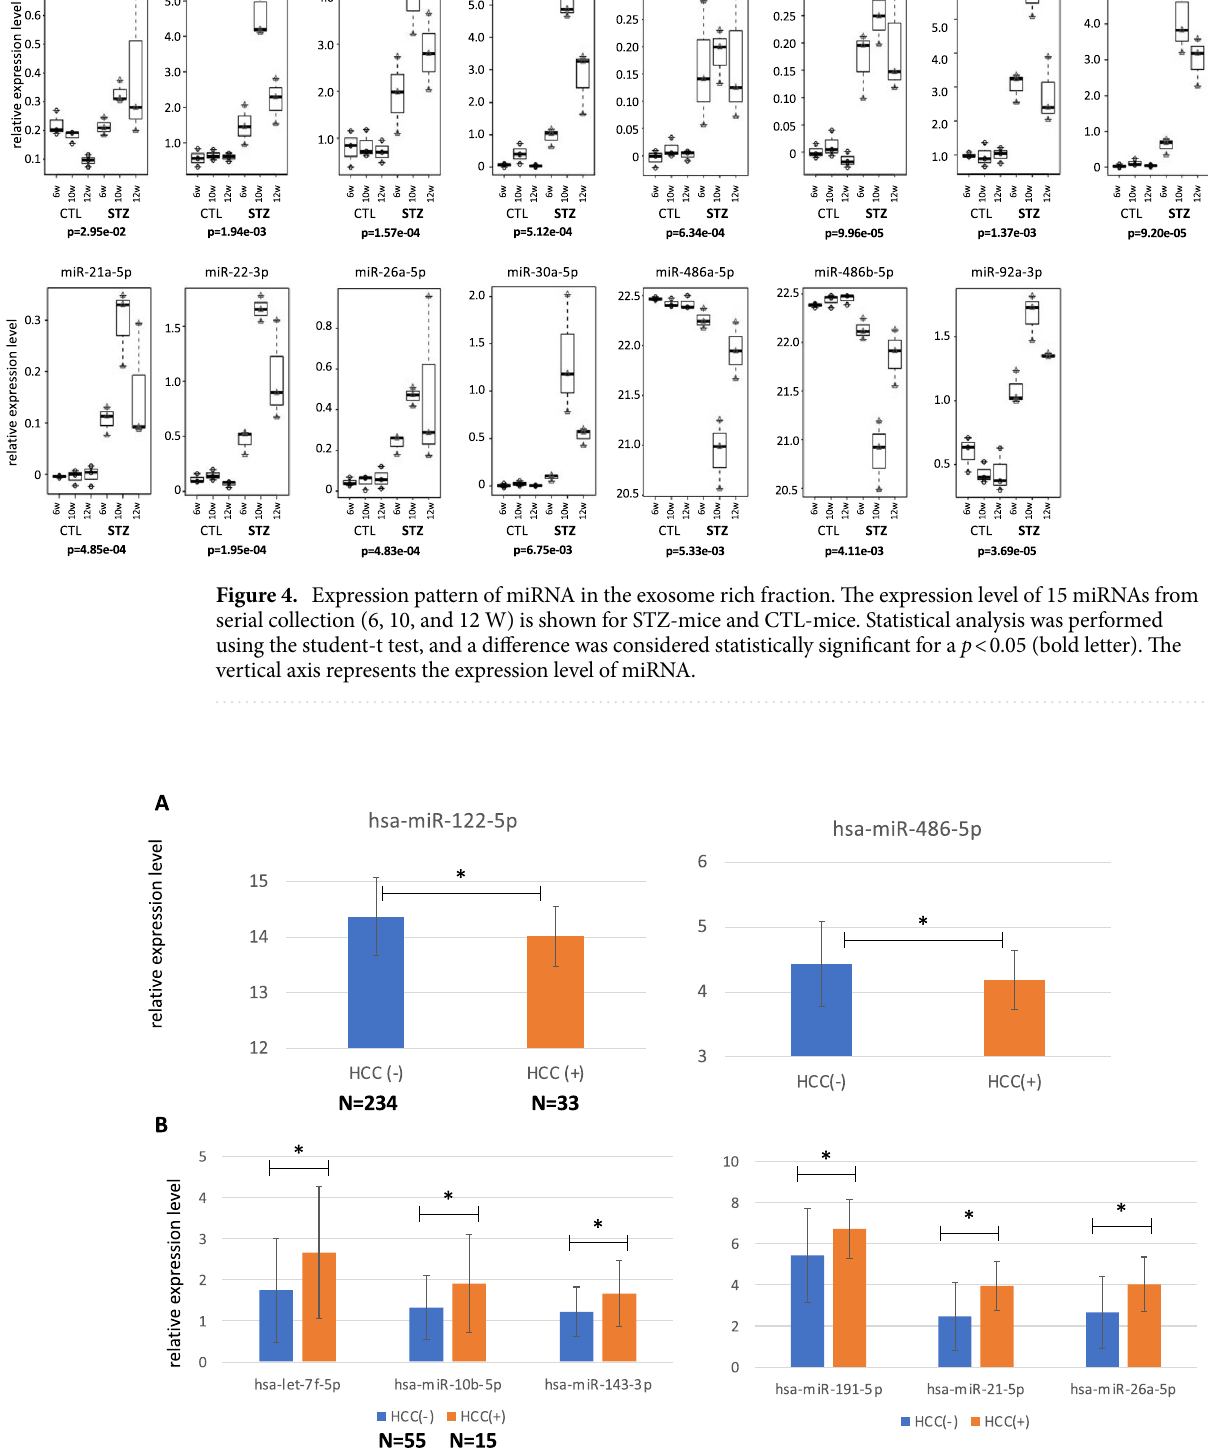
Figure 5. Analysis of miRNA expression in specimens collected before the antiviral treatment. Expression of hsa-miR-122-5p and 486-5p in the liver tissue ( A ) and expression analysis of hsa-let-7f-5p, miR-10b-5p, miR-143-3p, miR-191-5p, miR-21-5p, and miR-26a-5p in the exosome rich fraction ( B ) are shown, respectively. Statistical analysis was performed using the student-t test, and a difference was considered statistically significant for a p <